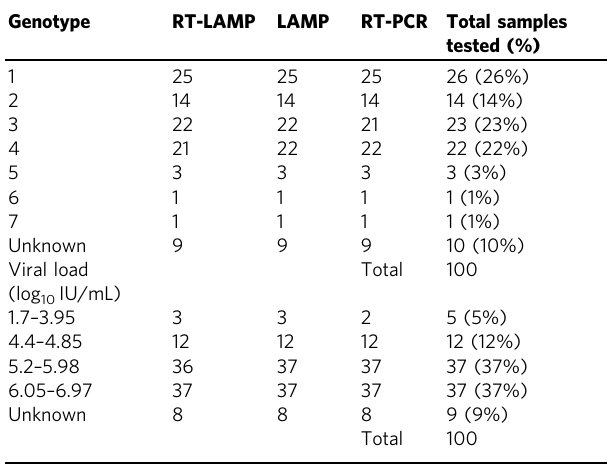
Experimentswereperformed induplicateandatleast onepositivereplicatewasinterpreted asa positive result.